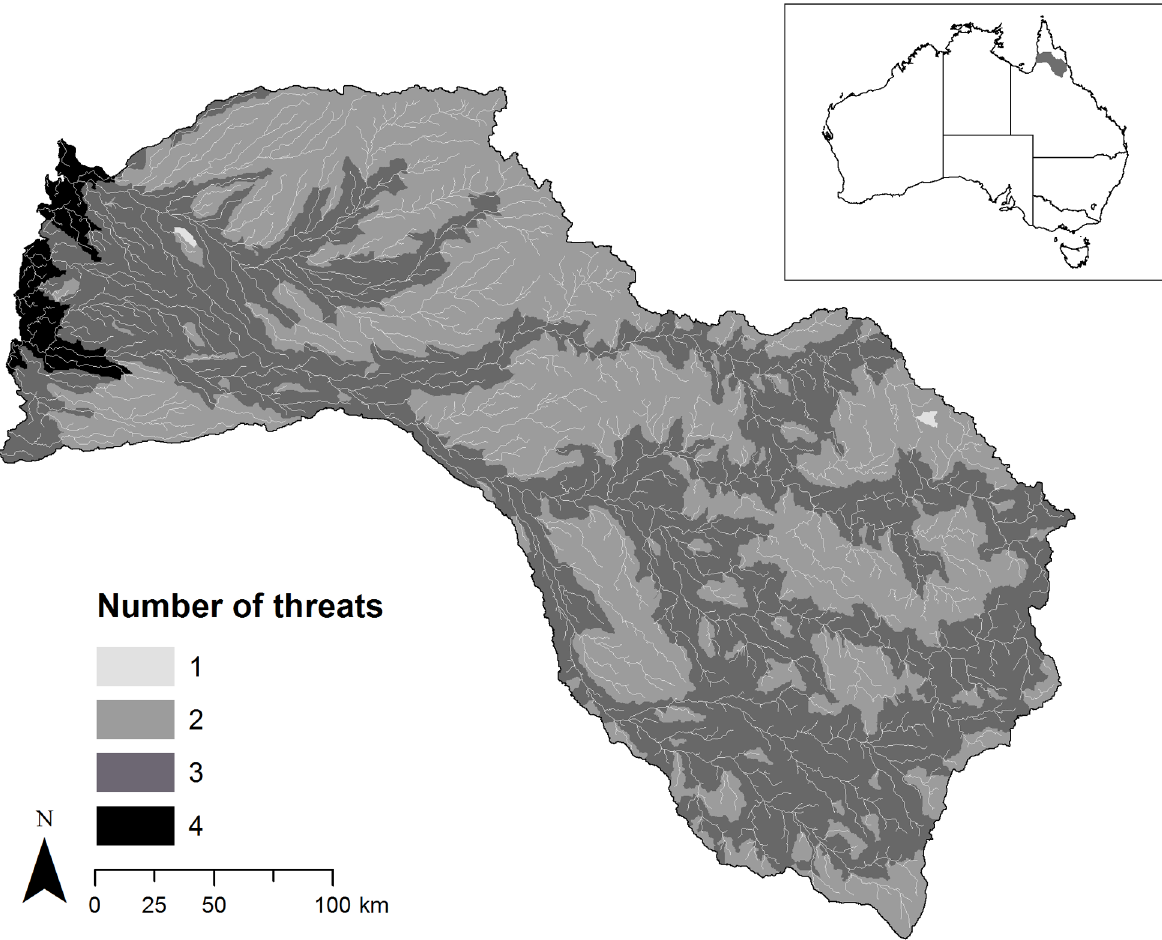
Fig 2. Spatial distribution of the occurrence of the threats in the case study area. Occurrence data represent presence or absence of a threat in each site. Threats include (1) water buffalo, (2) cane toad, (3) river flow alteration and (4) grazing land use.